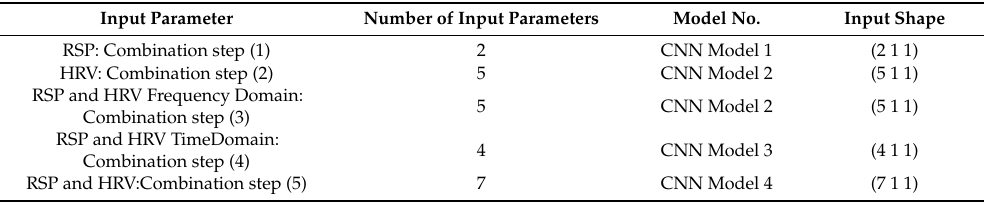
Table 3. Variation of input shape depending on input